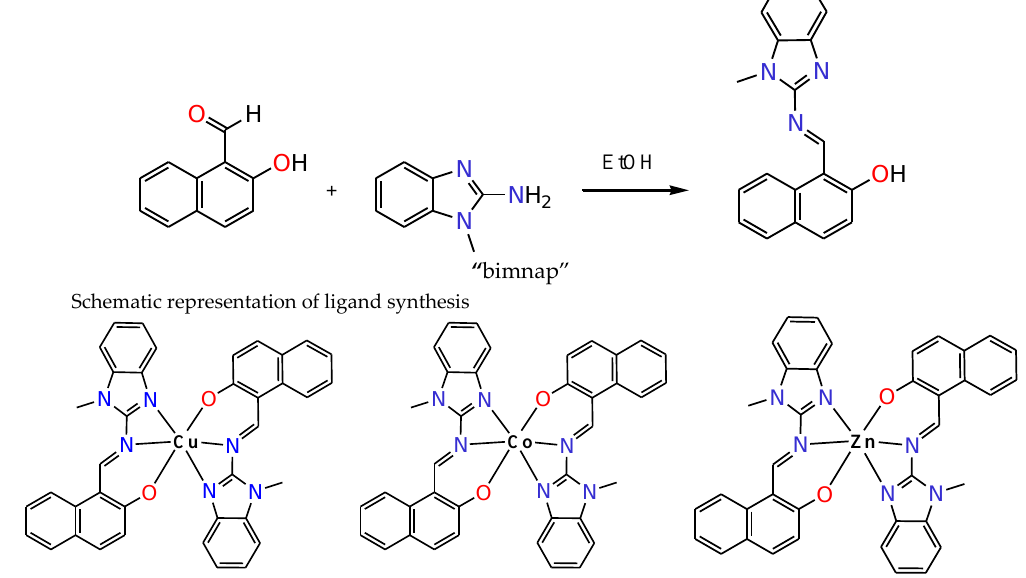
Figure 1. Schematic representation of the ligand synthesis and proposed structures of the Cu(II) ( 1 ), Co(II) ( 2 ), and Zn(II) ( 3 ) complexes.